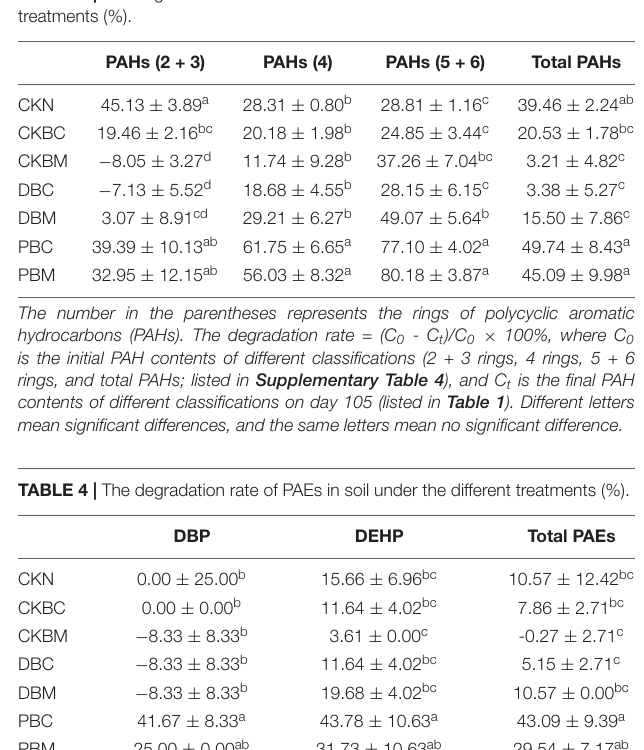
TABLE 3 | The degradation rate of 16 PAHs in soil under the different treatments (%).